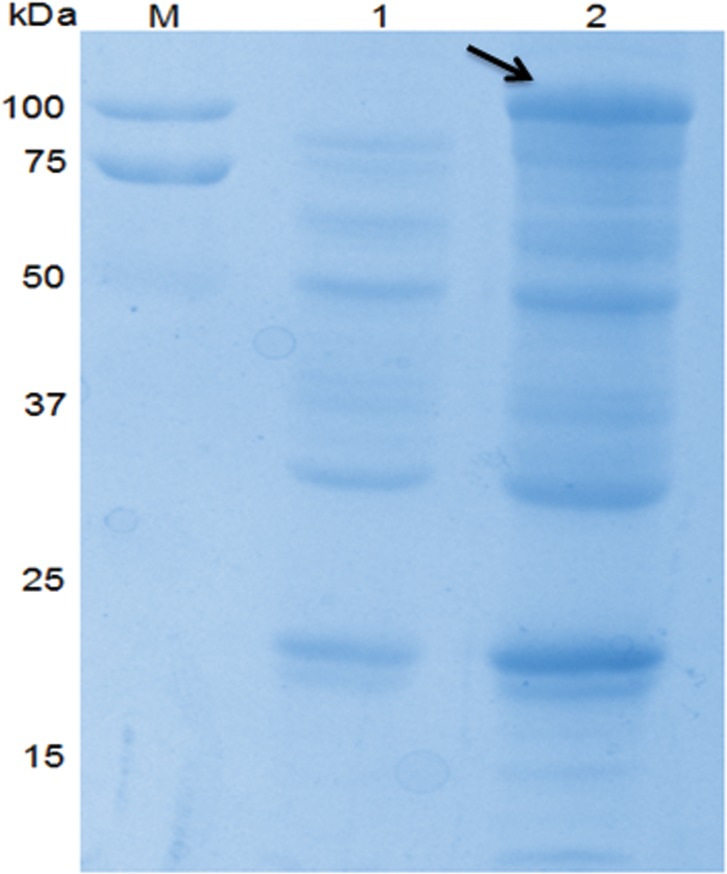
SDS-PAGE of JC8031 recombinant strain.Lane M: protein marker. Lane 1: JC8031-pBAD. Lane 2: JC8031- pBAD -Apxr.